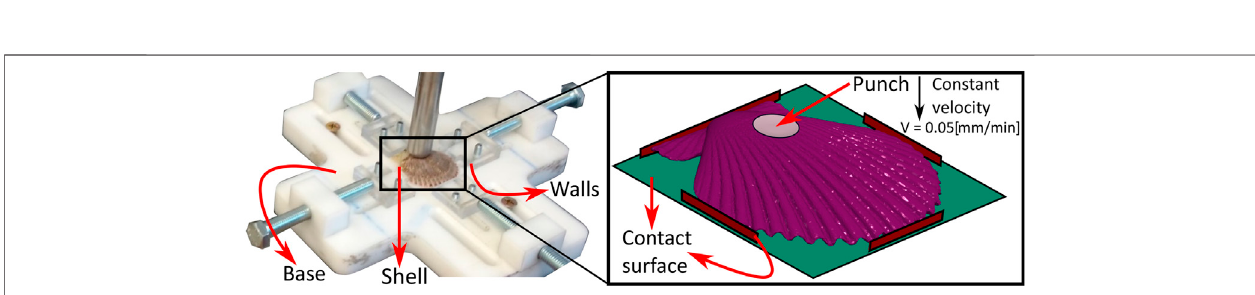
FIGURE2| Flexocompressiontestcon fi guration:Thebaseforthe fl exo-compressiontestandthetestcon fi gurationareshown,inwhichthepunchislocatedatthe cusp of the shell (outer